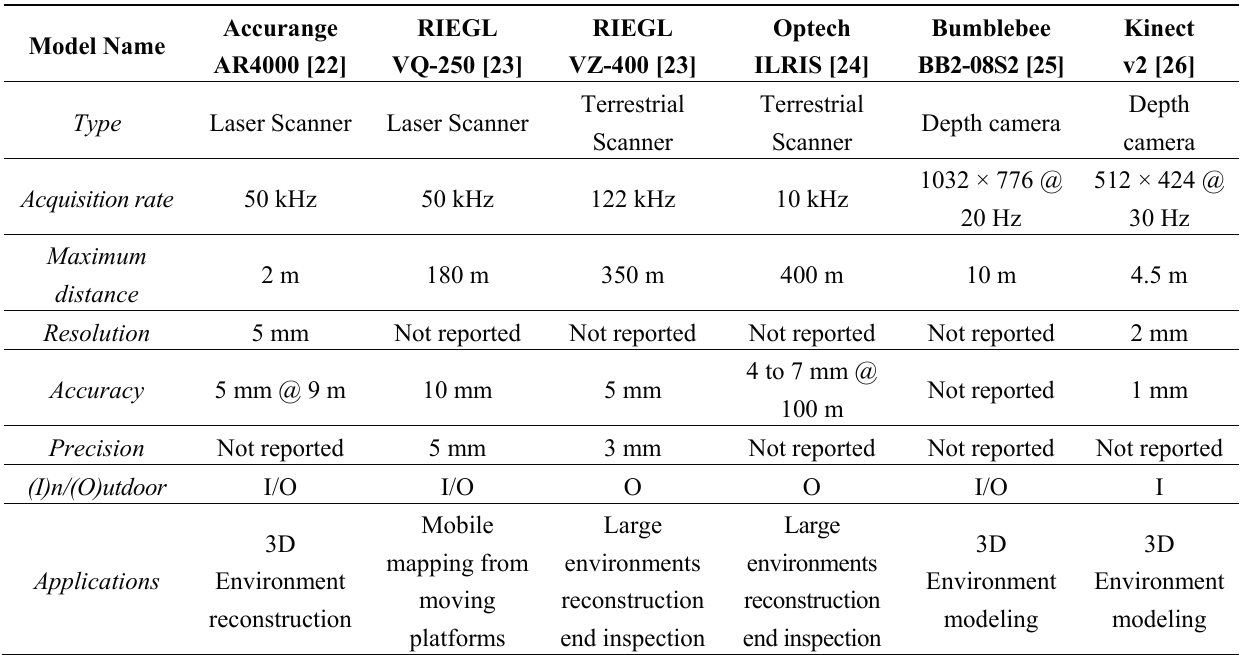
Table 1. List of available devices for 3D reconstruction of